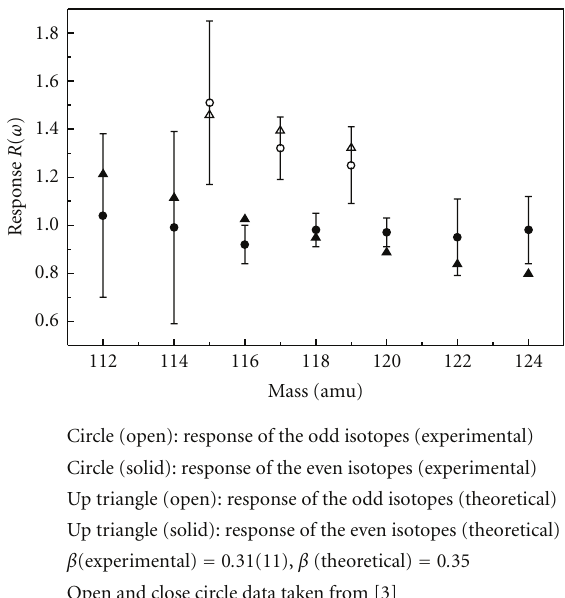
Figure 3: Response of the tin isotopes for the 5p 2 ( 3 P 0 ) − 5p 6s ( 3 P 0 ) (286.3317nm ) transition computed for an excitation laser 1 linewidth of 12 GHz.